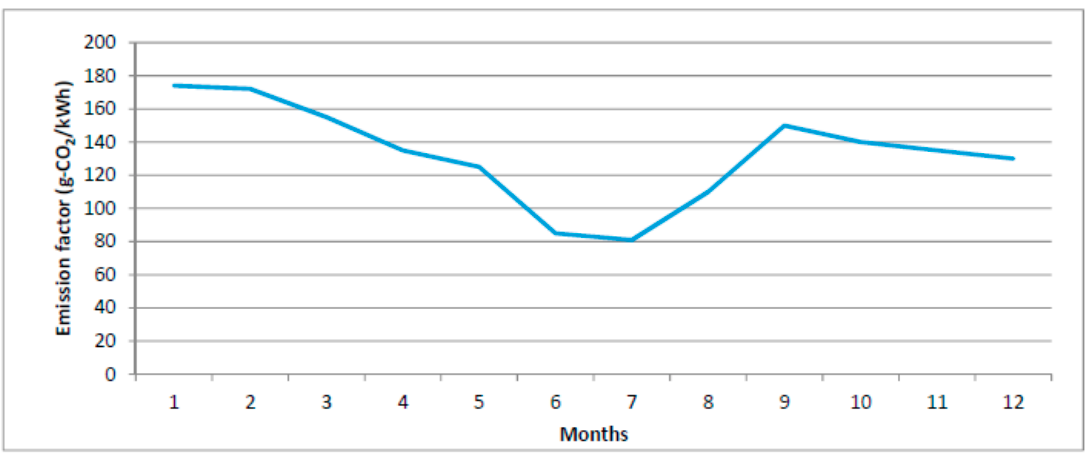
Figure 7. The average monthly emissions of the electrical grid of Finland [19,26].